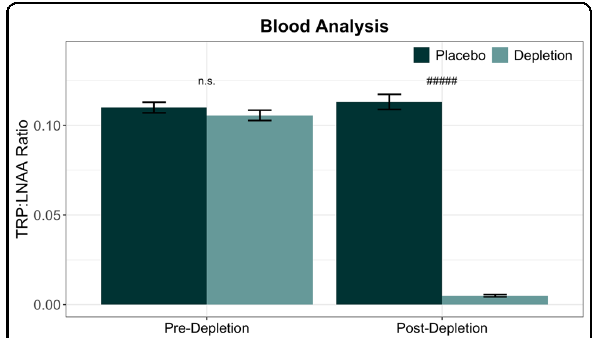
Fig. 4 Blood analysis results. Error bars represent 1 standard error. Signi fi cance at p < 5 ×10 − 27 is denoted by #####. n.s. denotes not signi fi